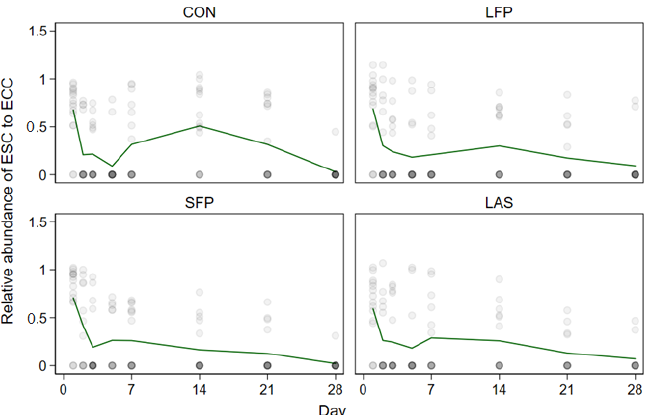
Figure 5. Abundance of ESC-resistant E. coli relative to total E. coli in rectal swabs from ESC-resistant E. coli challenged weaners belonging to different treatment groups. Line represents median with individual pigs represented by dots (overlapping of individual pig data results in darker dots in graph). Treatment abbreviations: CON = control diet, LFP = CON + 2000 ppm Lactobacillus acidophilus fermentation product (LFP), SFP = CON + 2000 ppm Saccharomyces cerevisiae fermentation product (SFP), LAS = CON + 2000 ppm LFP + 2000 ppm SFP.